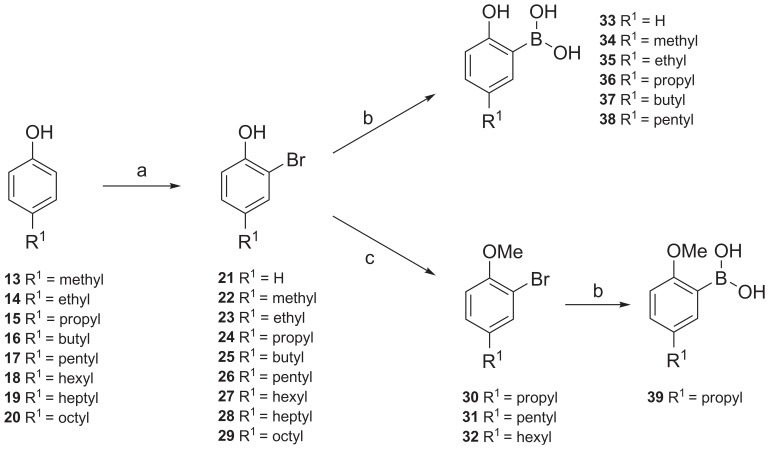
Synthesis of intermeditates.(a) Br2, NaHCO3, CHCl3, 0°C; (b) three steps, (1) n-butyllithium, Et2O, −78°C; (2) B(OCH3)3, Et2O, −78°C to rt; (3) HCl, Et2O; (c) CH3I, NaOH, benzyl-tri-n-butylammonium bromide, CH2Cl2 : H2O (1∶ 1), 12 h, rt.